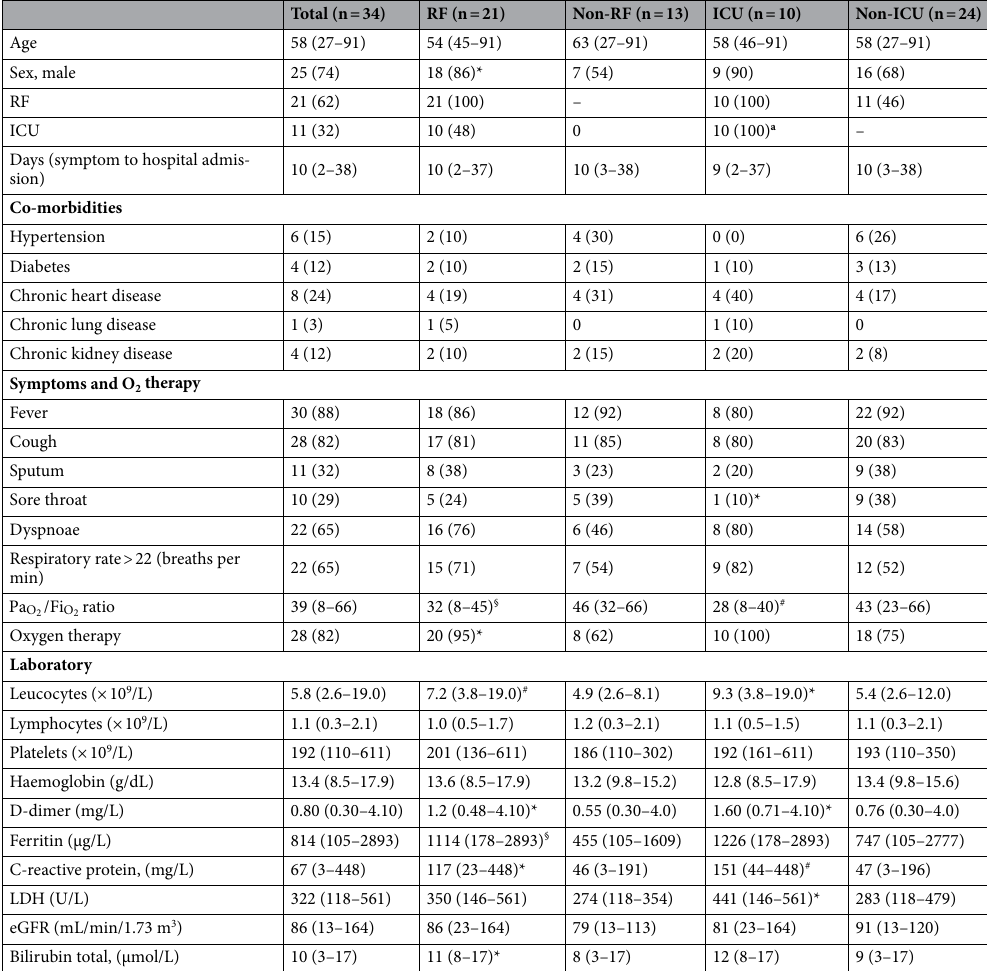
Table 1. Patient characteristics. Data are given as median (range), n (%). Significance indicated with * p < 0.05, # p < 0.01, § p < 0.001. a One patient who died was in need of ICU but was not transferred due to high